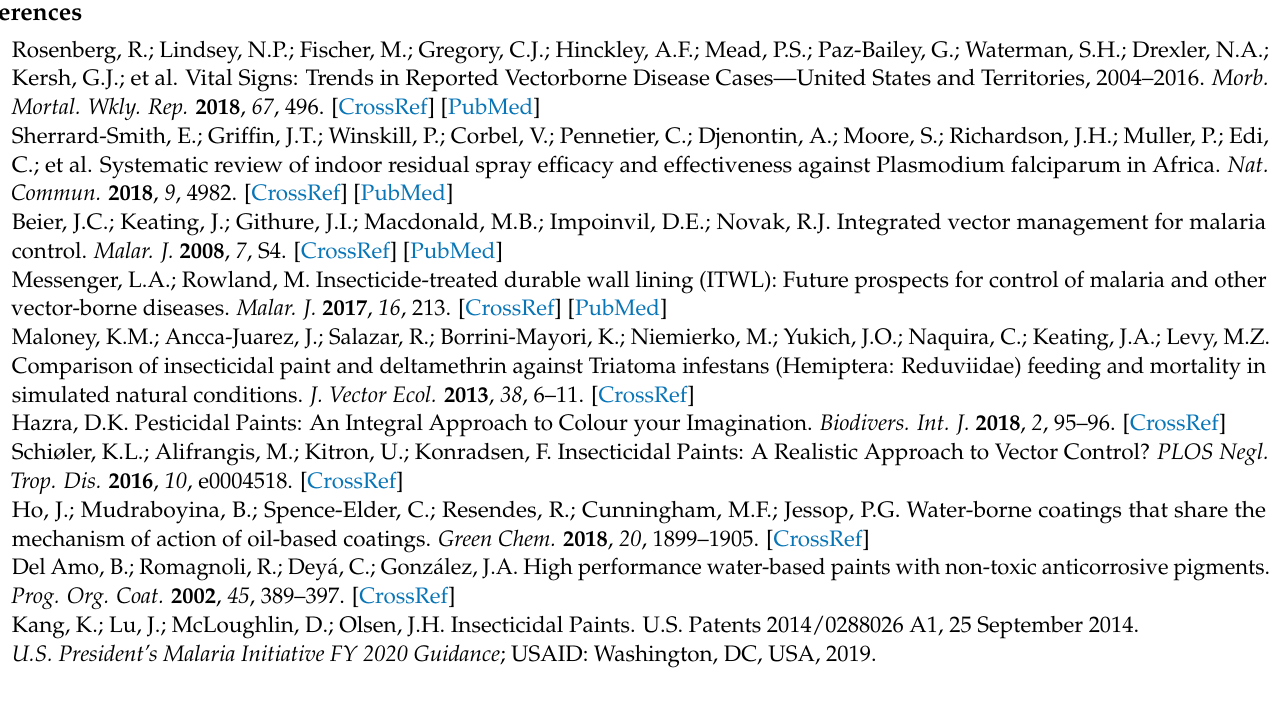
NMR spectrum of a -DLM, Figure S2: HPLC chromatogram, Table S1: Proton chemical shift measured for a -DLM and i -DLM, Figure S3: 1 H NMR spectra of a -DLM in ACN-d 3 /H 2 O, solution A and solution B, Table S2: Quantitative composition of a -DLM (solution A) at room temperature, Table S3: Quantitative composition of a -DLM (solution B) at room temperature, Figure S4: Degradation of a -DLM at room temperature in solution A, Table S4: Quantitative composition of a -DLM (solution A) at 40 ◦ C, Table S3: Quantitative composition of a -DLM (solution B) at 40 ◦ C, Figure S5: DOSY map of 3-PBA, Figure S6: HPLC chromatogram of a -DLM stressed sample, Figure S7: 1 H NMR spectra of stressed sample and compounds isolated from fraction collection, Figure S8: 1 H NMR spectra in cyclohexane over time, Figure S9: 1 H NMR spectra in ACN-d 3 /H 2 O over time, Figure S10: HSQC maps, Figure S11: 1 H NMR quantitative spectrum, Figure S12: TOF MS-ESI + spectra, Figure S13: GC-MS chromatograms, Figure S14: EI-MS spectra, Figure S15: 1 H NMR spectra comparison, Characterization data and 2D NMR